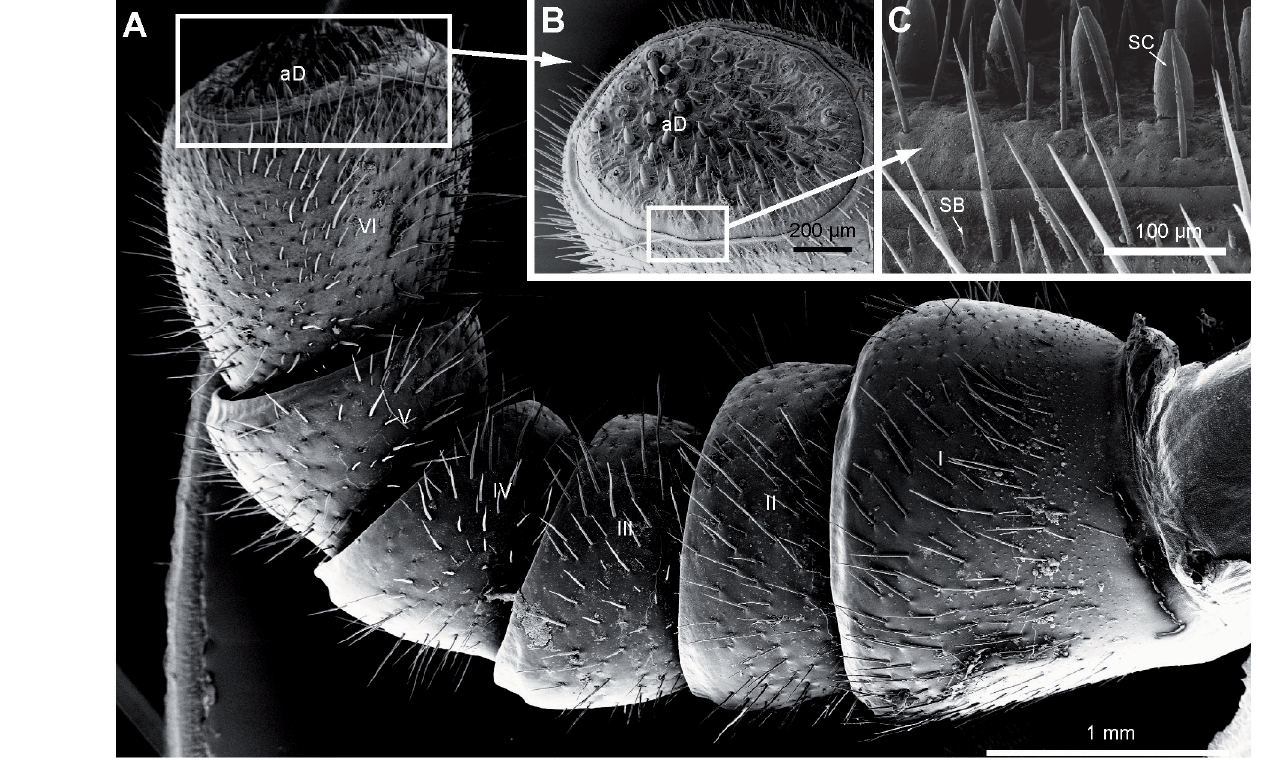
Fig. 2. Sphaeromimus kalambatritra sp. nov., SEM of left antenna, ♂, holotype ( CASENT 9068297- A). A . Overview. B . Antennal disc, detail. C . Margin of antennal disc, detail. Abbreviations: aD = antennal disc; SB = sensilla basiconica; SC = sensory cone; I–VI